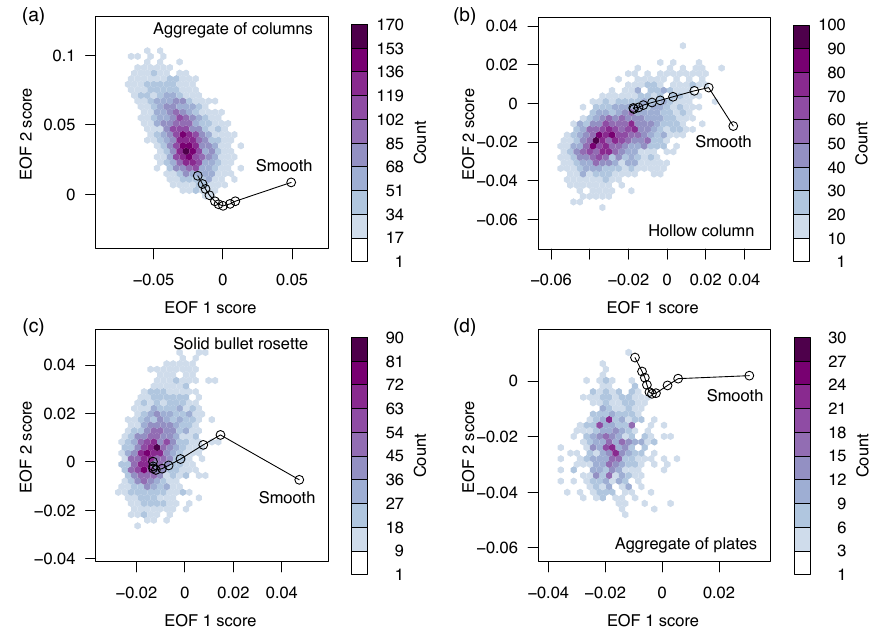
Figure 14. Distributions of EOF 1 and EOF 2 scores with different particle shapes. The observation frequency is shaded with color, and the solid line connects the EOF scores for 10 prescribed roughness values (circles). (a) The result of inference with aggregate of columns, (b) hollow column, (c) solid bullet rosette, and (d) aggregate of plates.